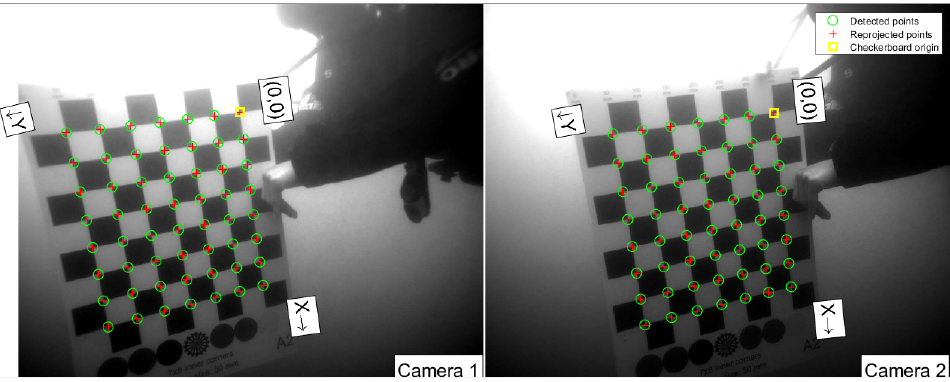
Figure 4. Example of an image pair used for the calibration with the Matlab camera calibration toolbox [58]